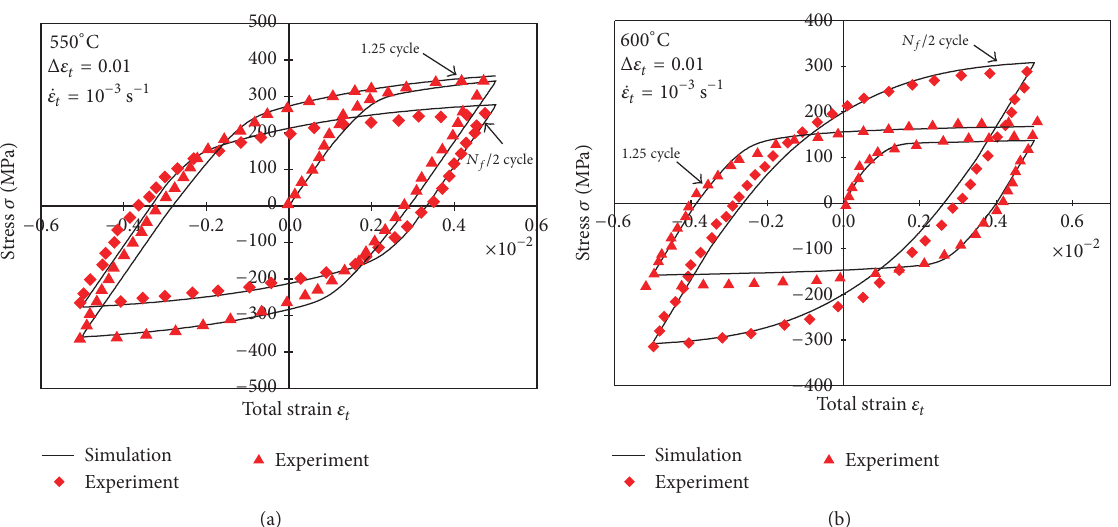
Figure 5: Stress-strain hysteresis loops at first and half-life cycles for 0.01 strain range for (a) a modified 9Cr-1Mo steel and (b) a 316 stainless